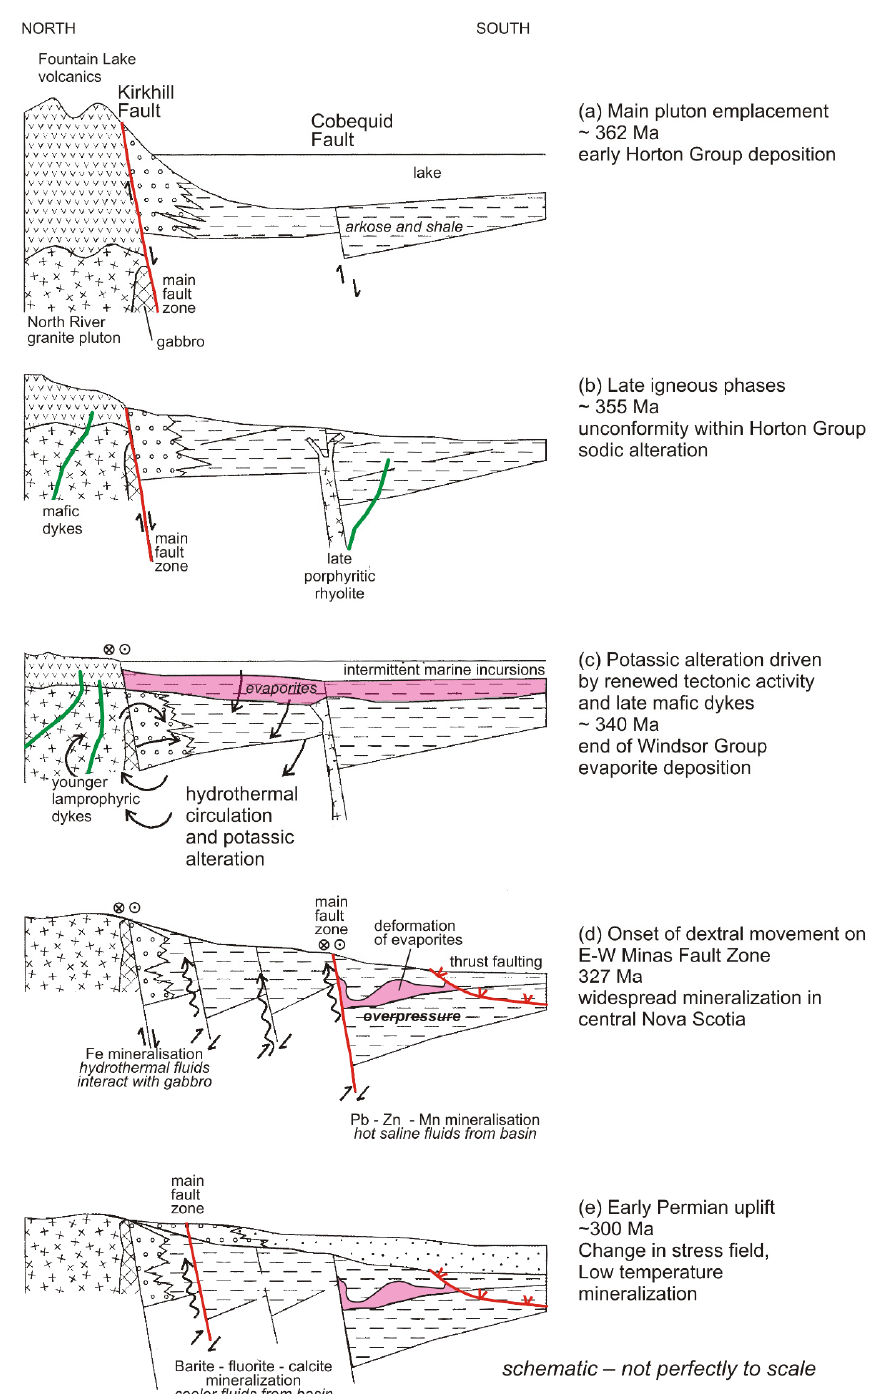
Figure 13. ( a – e ) Sequential evolution of the southern of the Cobequid Highlands through the Car-